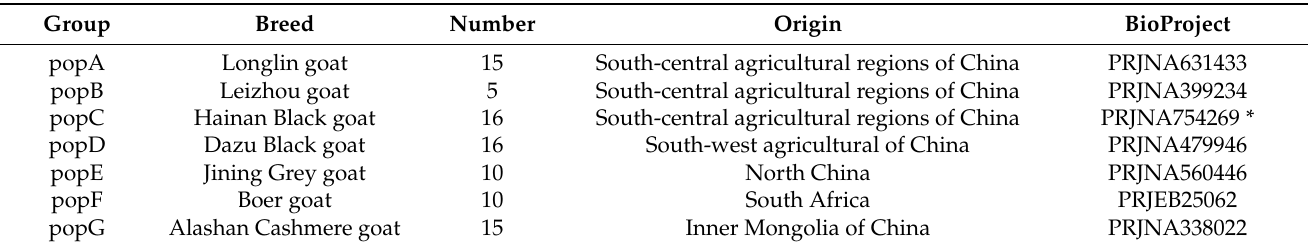
Table 1. Sample data